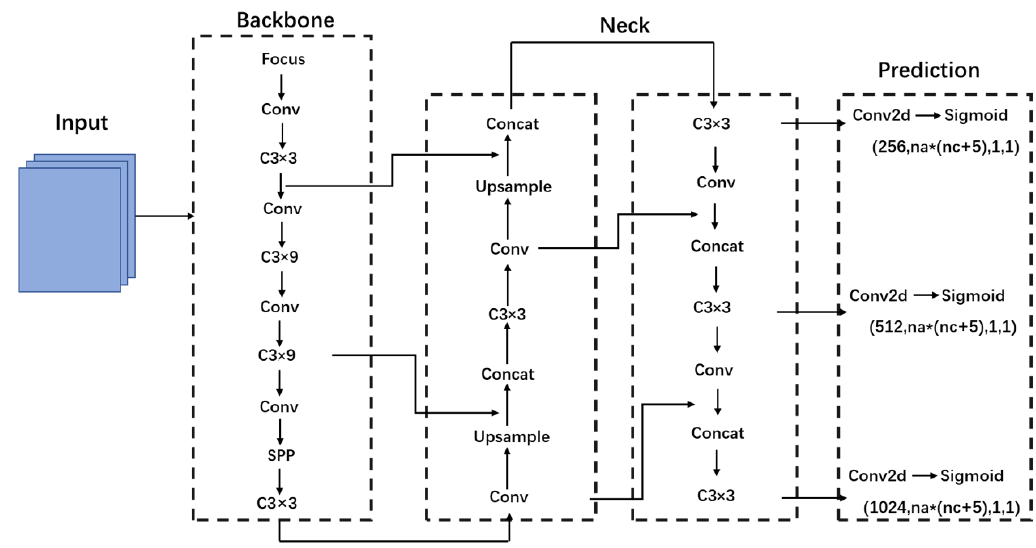
Figure 3. YOLOv5 structure diagram.